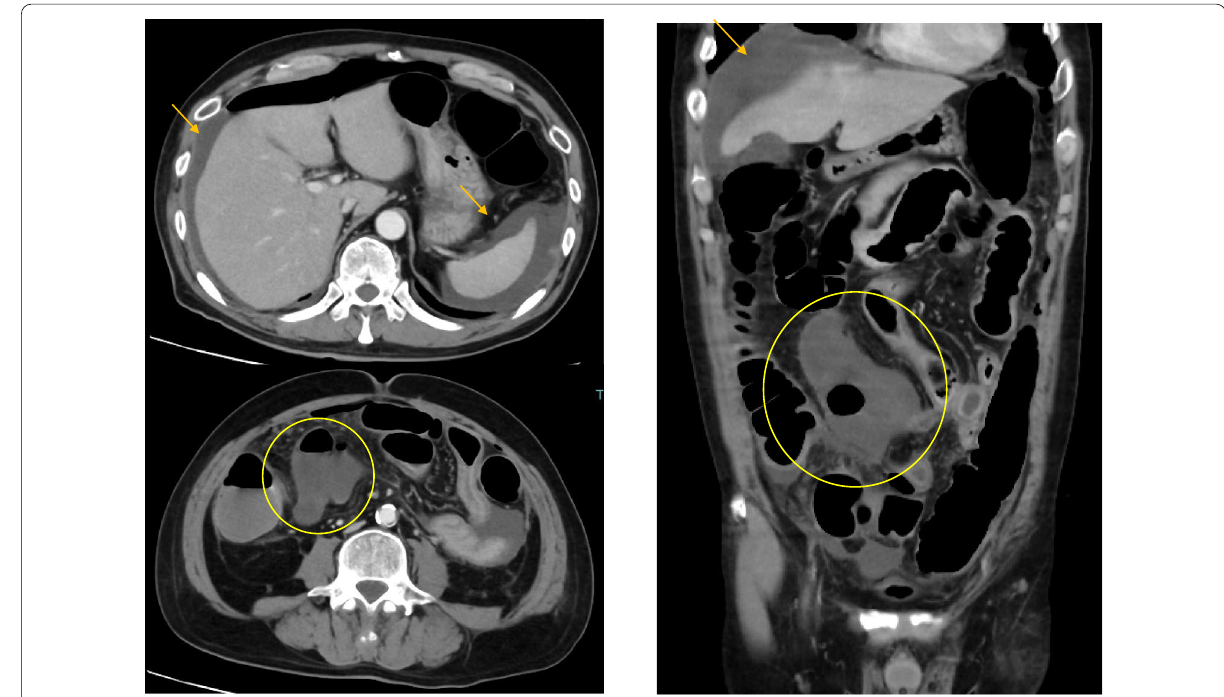
Fig. 2 Abdominal contrast-enhanced CT findings. (10th day after hospitalization): Ileum ischemia( ○ ) and ascites (